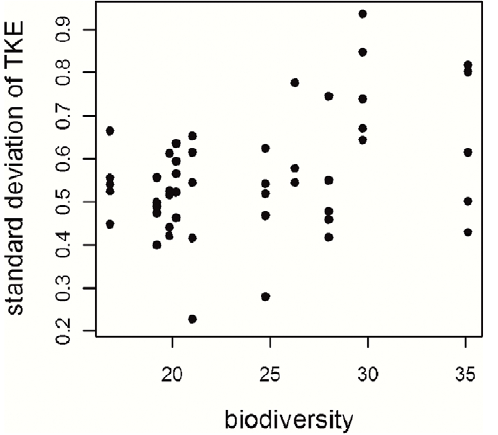
Figure 3. Relation between the standard deviation of TKE and biodiversity. Each dot represents a study plot.